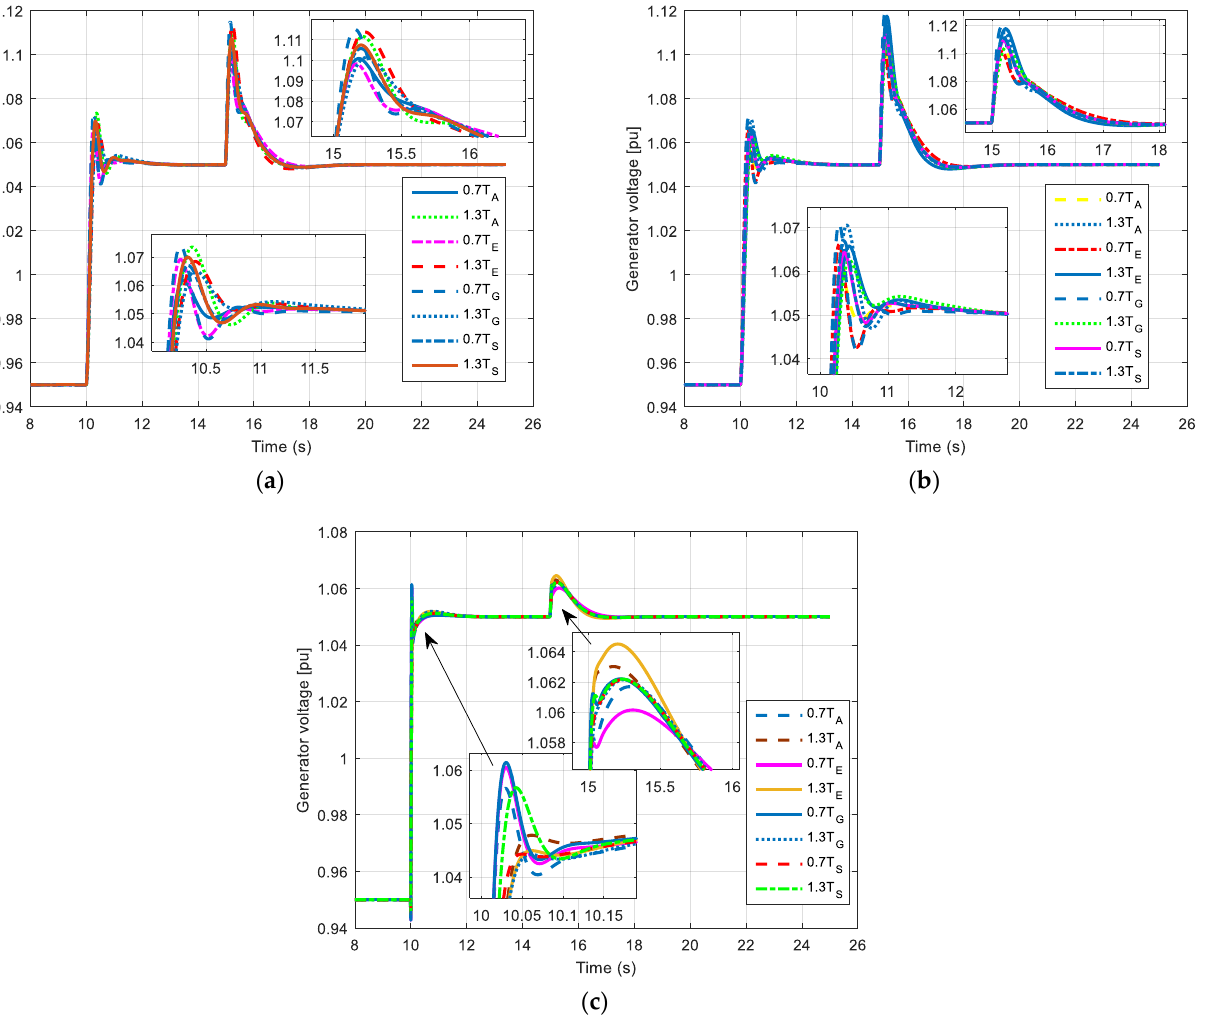
Figure 8. Testing the robustness of the system via different time constants in case of usage: ( a ) Ideal PID regulator, ( b ) Real PID regulator, and ( c ) PIDD2